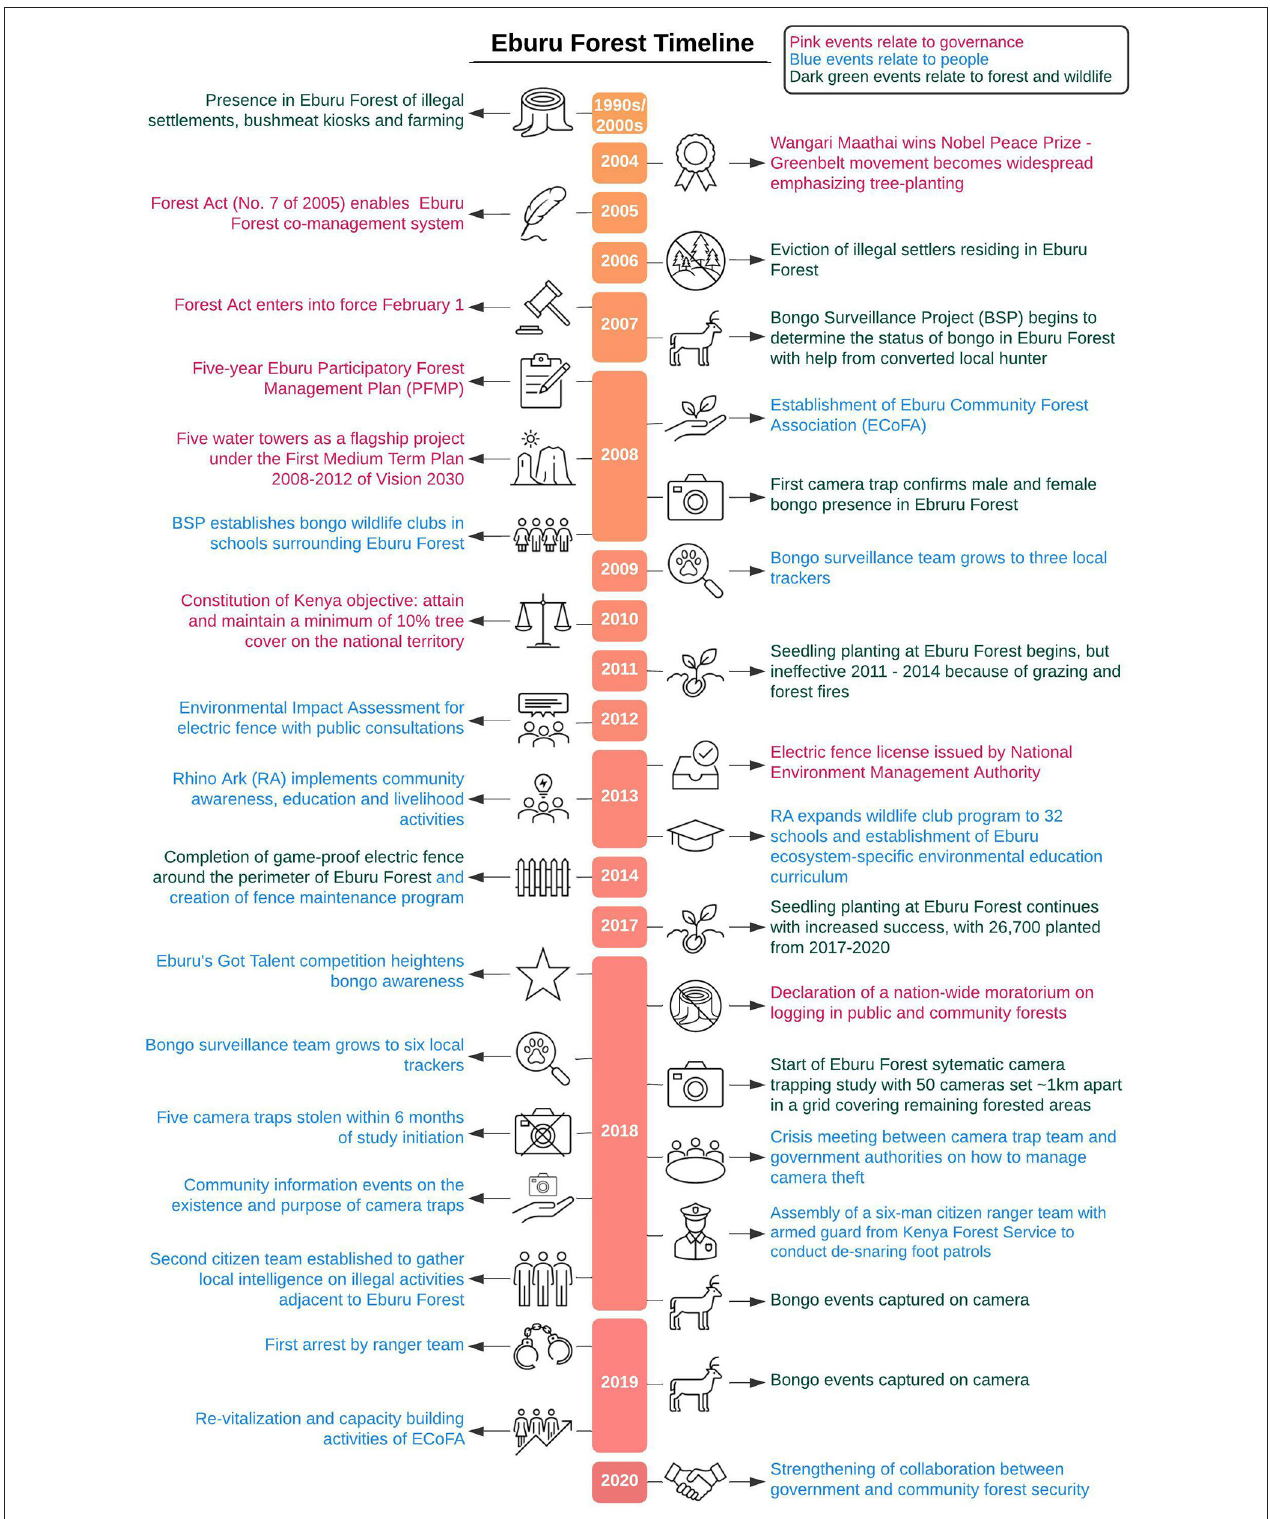
FIGURE 2 | Eburu forest timeline highlighting key conservation-relevant events from the 1990’s to 2020. Events in pink relate to governance, events in blue to impacts on local people and events in dark green to impacts on the forest and wildlife.